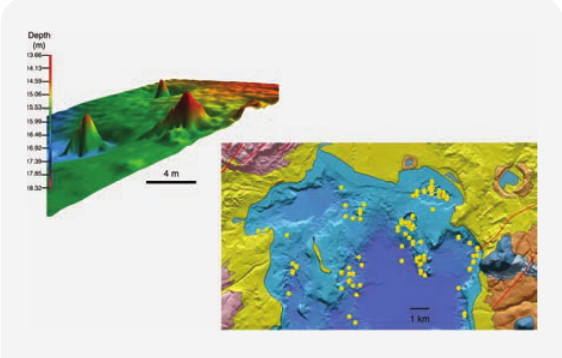
Figure 13. Hydrothermal vents in Yellowstone Lake. The vents emit streams of water that has been heated by circulation through hot fractured rock, that has in turn been heated by the magma reservoir deep below the surface. Images from Morgan et al. J. Volc.